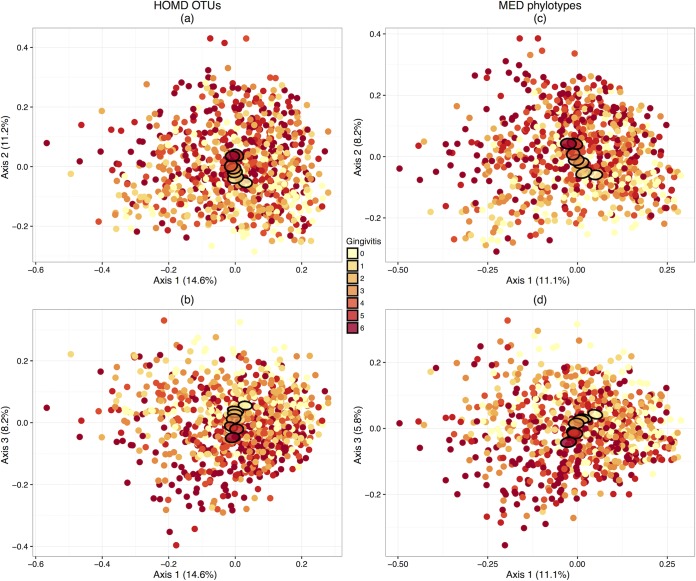
The PCoA ordination of supragingival plaque samples shows an approximate trend with gingivitis severity that is robust to analysis methods. PCoA ordinations based on Bray-Curtis dissimilarities between samples for 626 HOMD OTUs (a, b) and 502 MED phylotypes (c, d). Filled ellipses show mean values for each gingivitis severity, ranging from 0 (yellow) to 6 (dark red). In both cases, an approximate trend is visible, despite the noisiness of the data set. Before plotting, samples were rarefied to 5,000 reads to minimize the impact of sequencing depth.